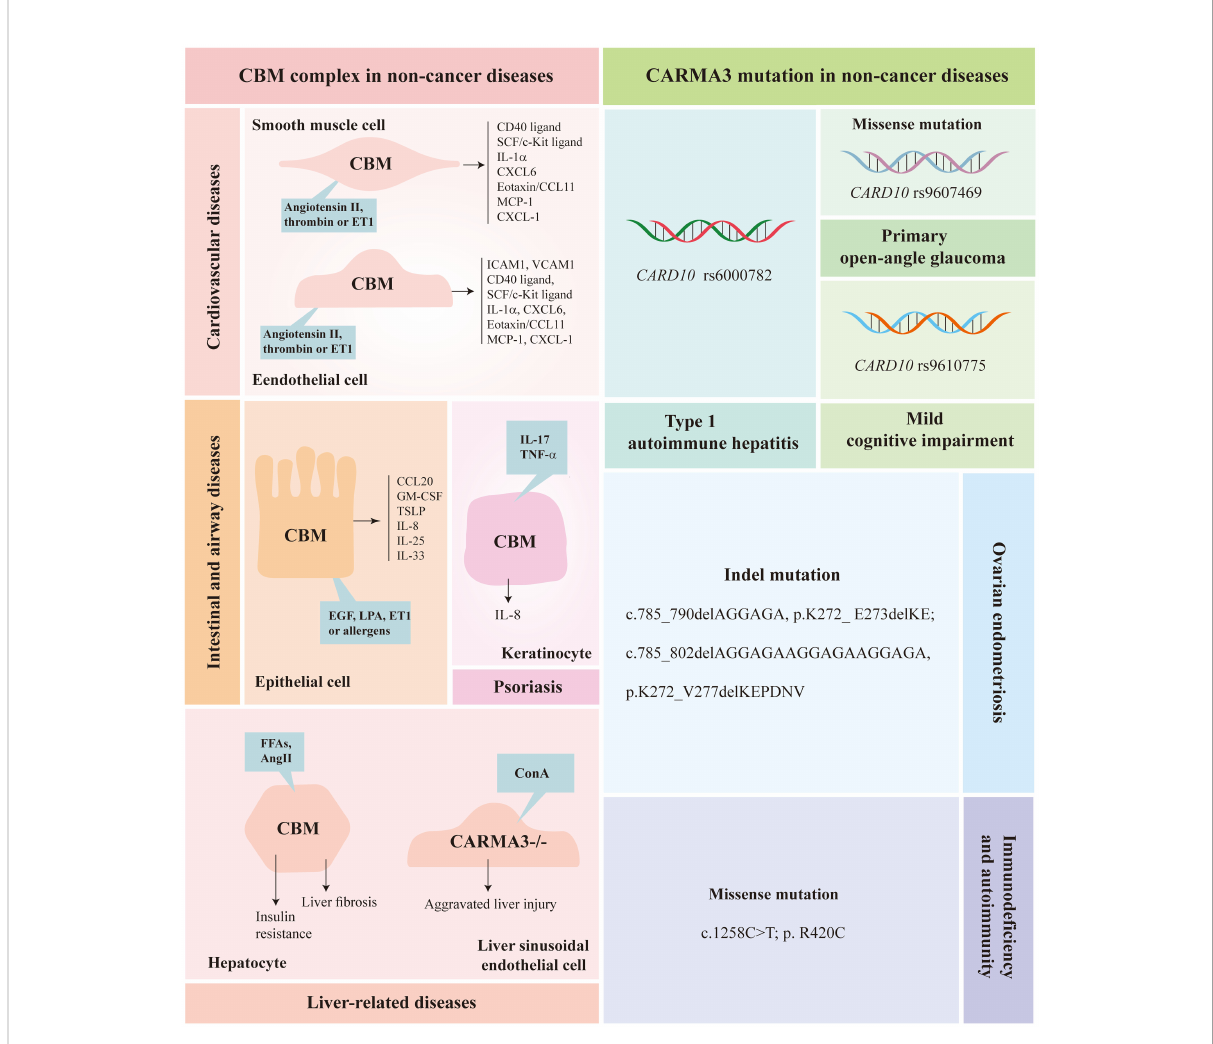
FIGURE 3 Overview of CARMA3 in non-cancer diseases. CBM complex are implicated in the pathogenesis of cardiovascular diseases, pulmonary diseases, liver-related diseases, intestinal disease and psoriasis; carma3 mutations are related to type1 autoimmune hepatitis, primary open-angle glaucoma, mild cognitive impairment, ovarian endometriosis and immunode fi ciency and